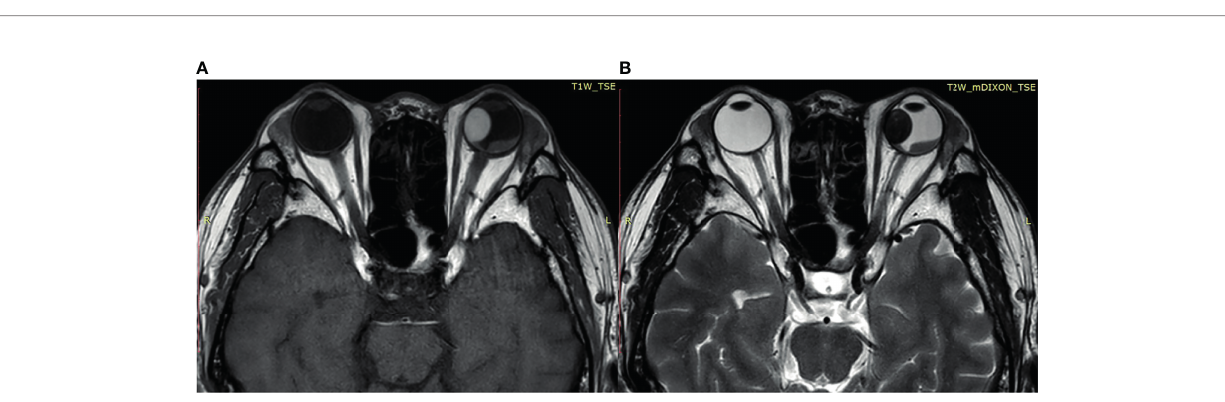
FIGURE 3 | (A) The tumor demonstrates a relatively bright signal on the T1-weighted image. (B) The tumor demonstrates a relatively low signal on the T2-weighted image.